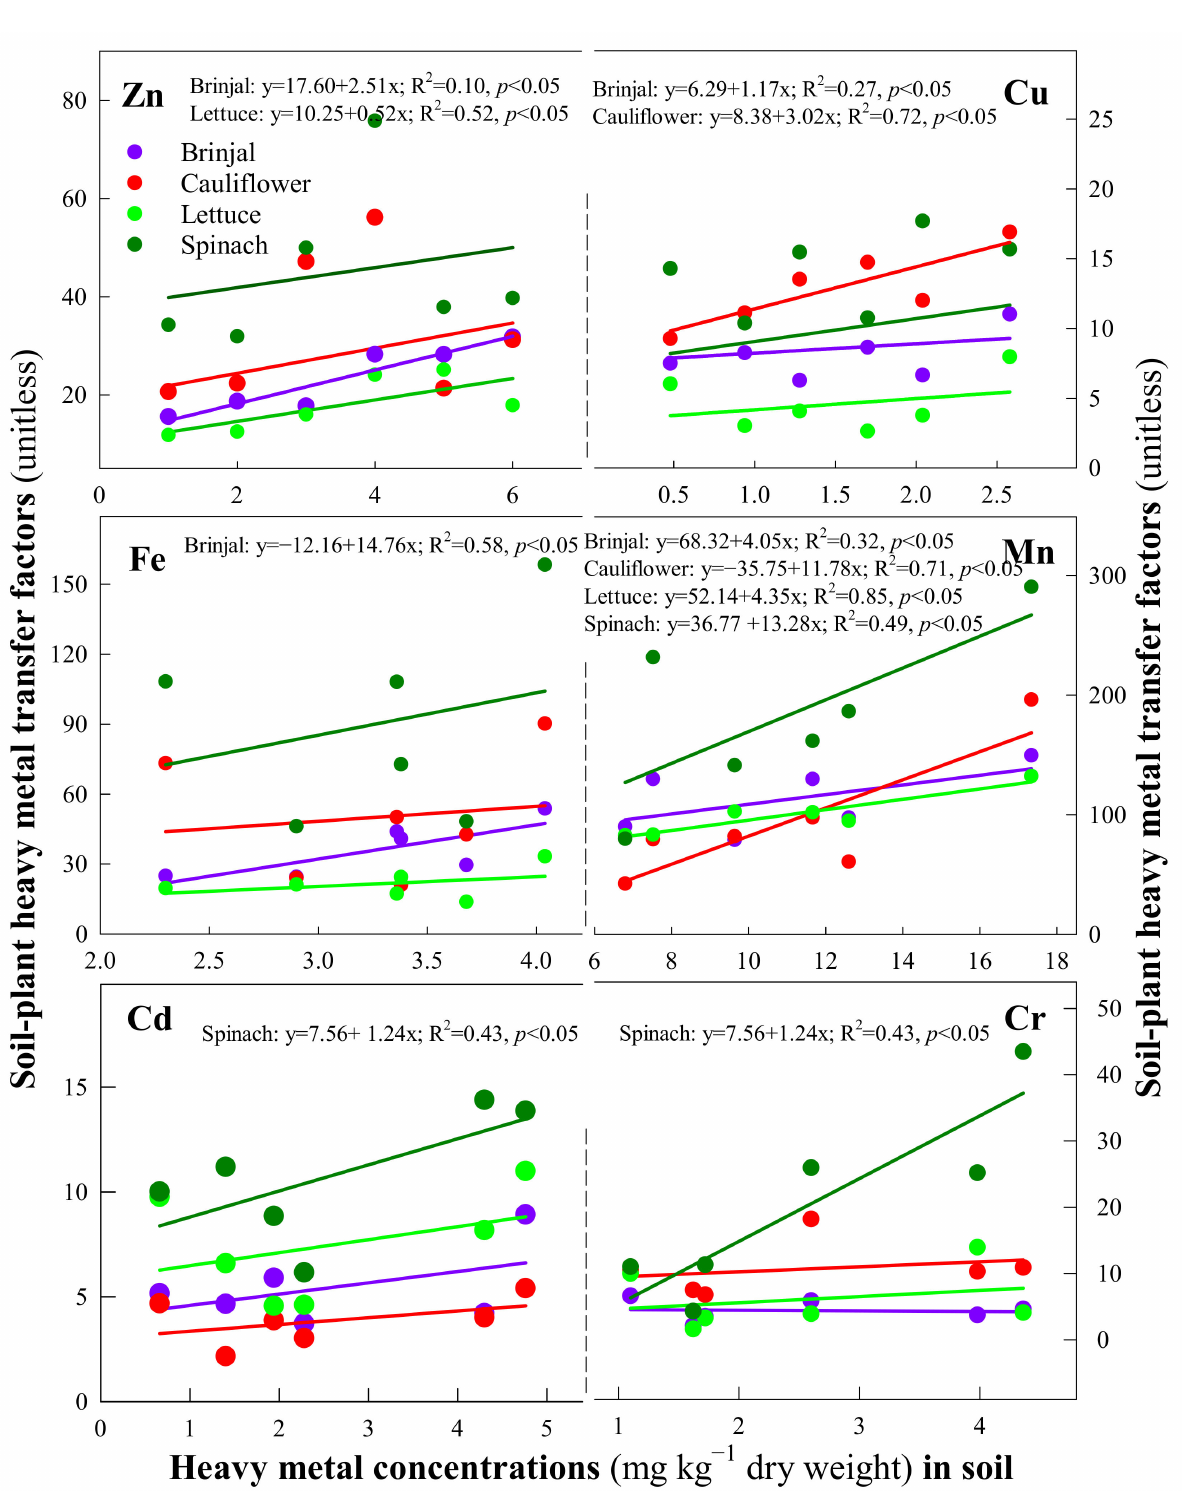
Figure 3. Relationships between the transfer factors (TF) of the vegetables (brinjal, cauliflower, lettuce, and spinach) and heavy metal (Zn, Cu, Fe, Mn, Cd, and Cr) concentrations (mg kg − 1 dry weight) in the respective soils of the Khan Village, Vehari road, Shujabad road, Industrial estate, Soraj miani, and Sameej abad study sites. A relationship is significant at p < 0.05. Only significant relationships are retained to sustain the brevity of the